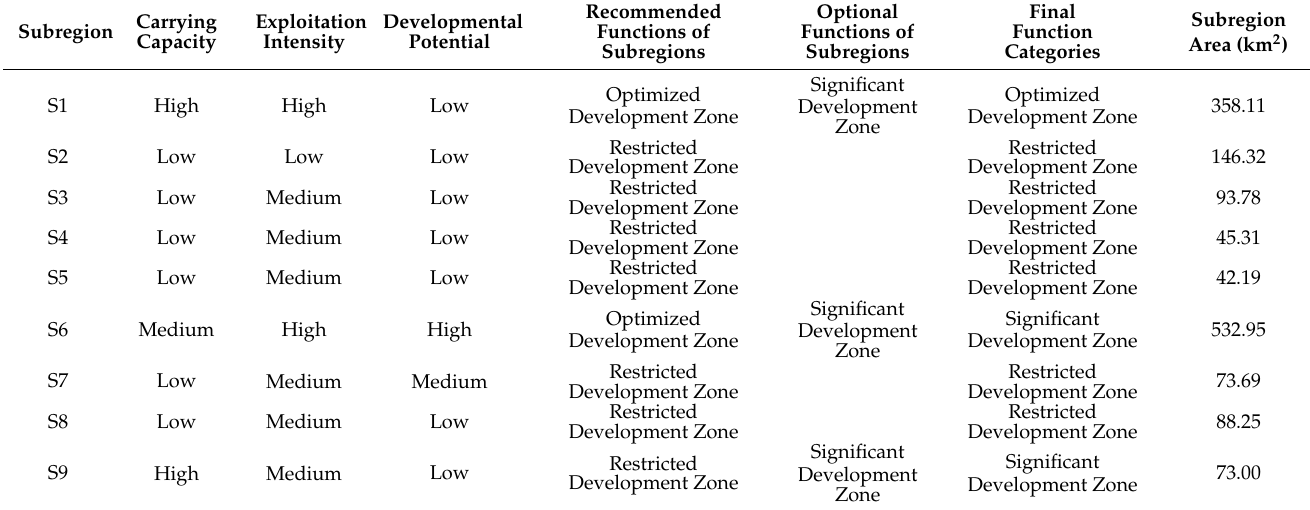
Table 7. Comprehensive evaluation results for the final functions of